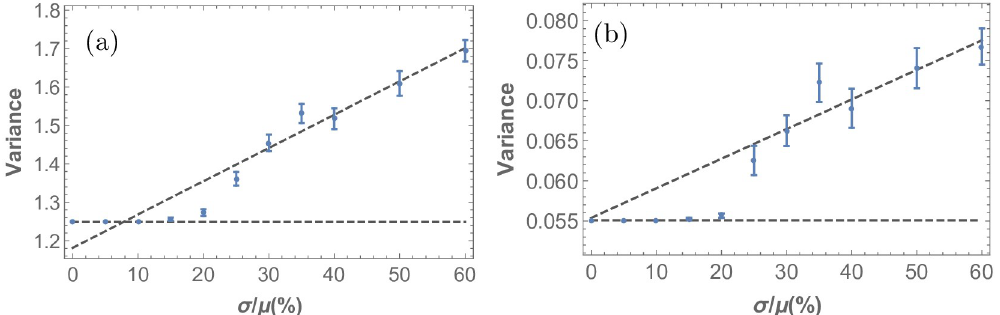
Fig 8. Disorder in the R8 cell point pattern of the developing Drosophila eye disc as a function of stochasticity. Here, the variance of the distributions of (a) nearest neighbor distances and (b) nearest neighbor angles is used to quantify the amount of disorder. As in the previous figure, stochasticity is introduced in the diffusivity of the morphogens D u and D s , and the x- axis represents the noise level in terms of the standard deviation of the underlying Gaussian distribution from which this parameter is drawn. As the noise level in the simulation is increased beyond a threshold, the variance grows.